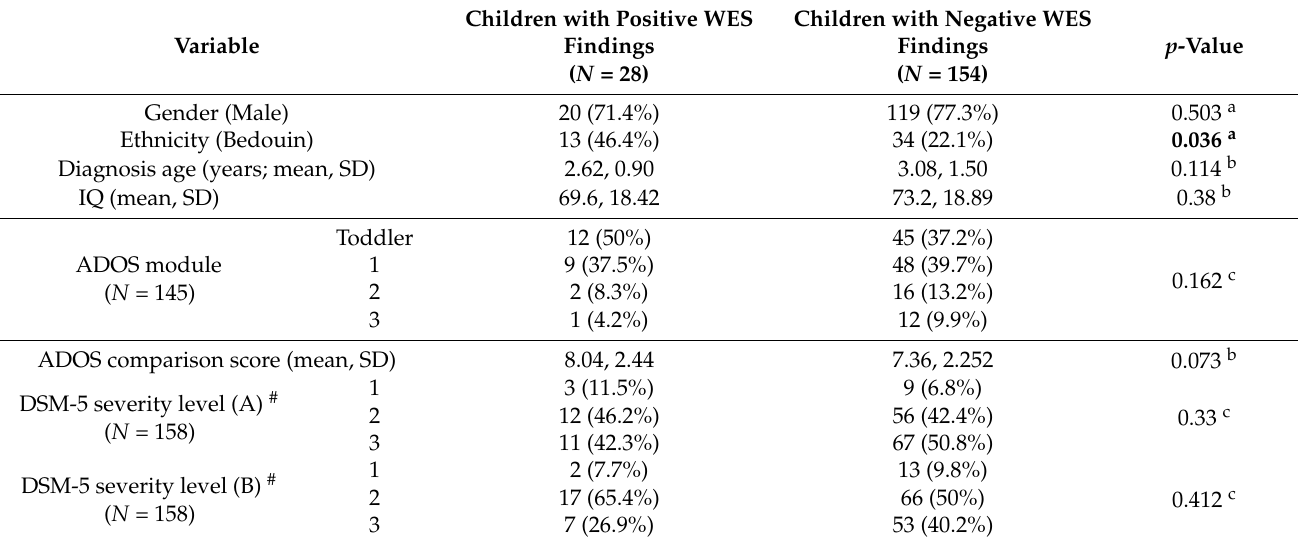
Table 2. Characteristics of 182 children with ASD for whom WES results were available.